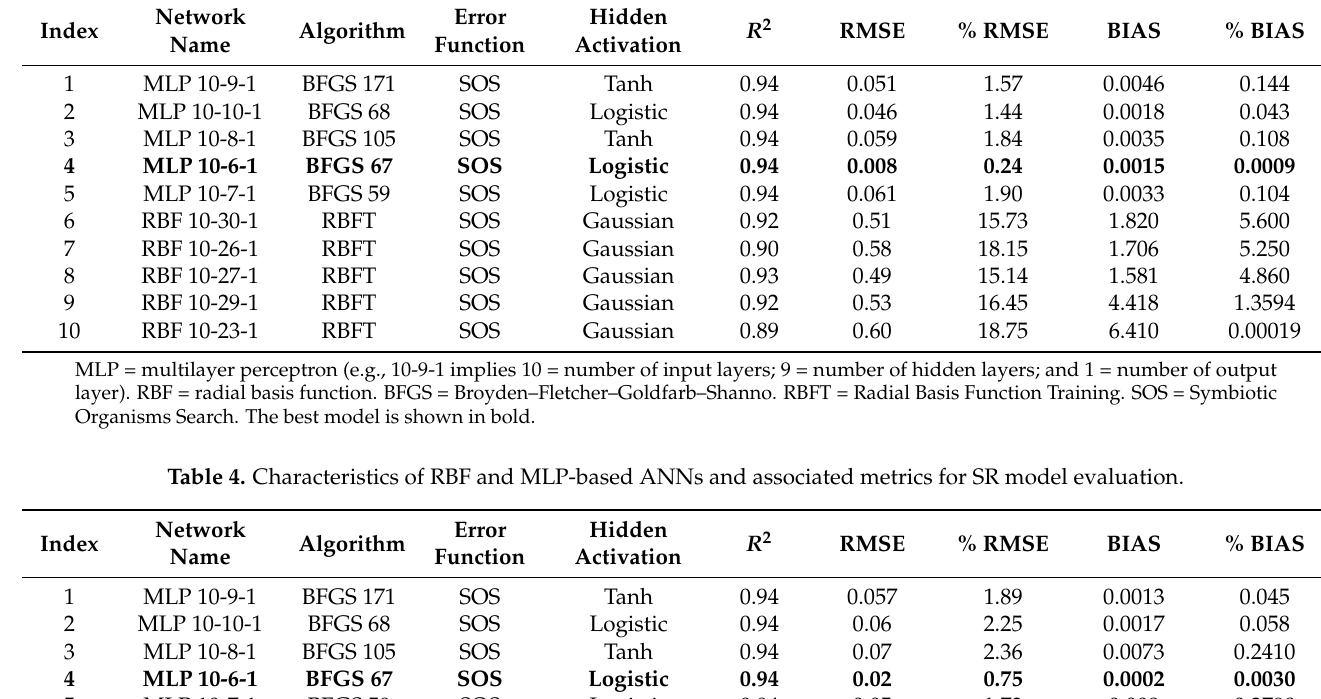
Table 3. Characteristics of RBF and MLP-based ANNs and associated metrics for SR model training.